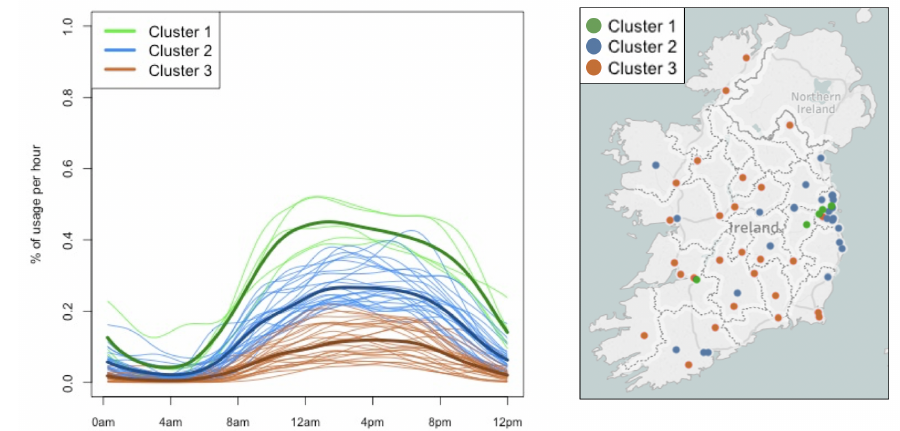
Figure 13. Functional clustering for Fast charging points (CHAdeMO – CSS – FastAC) and relative position on the map.